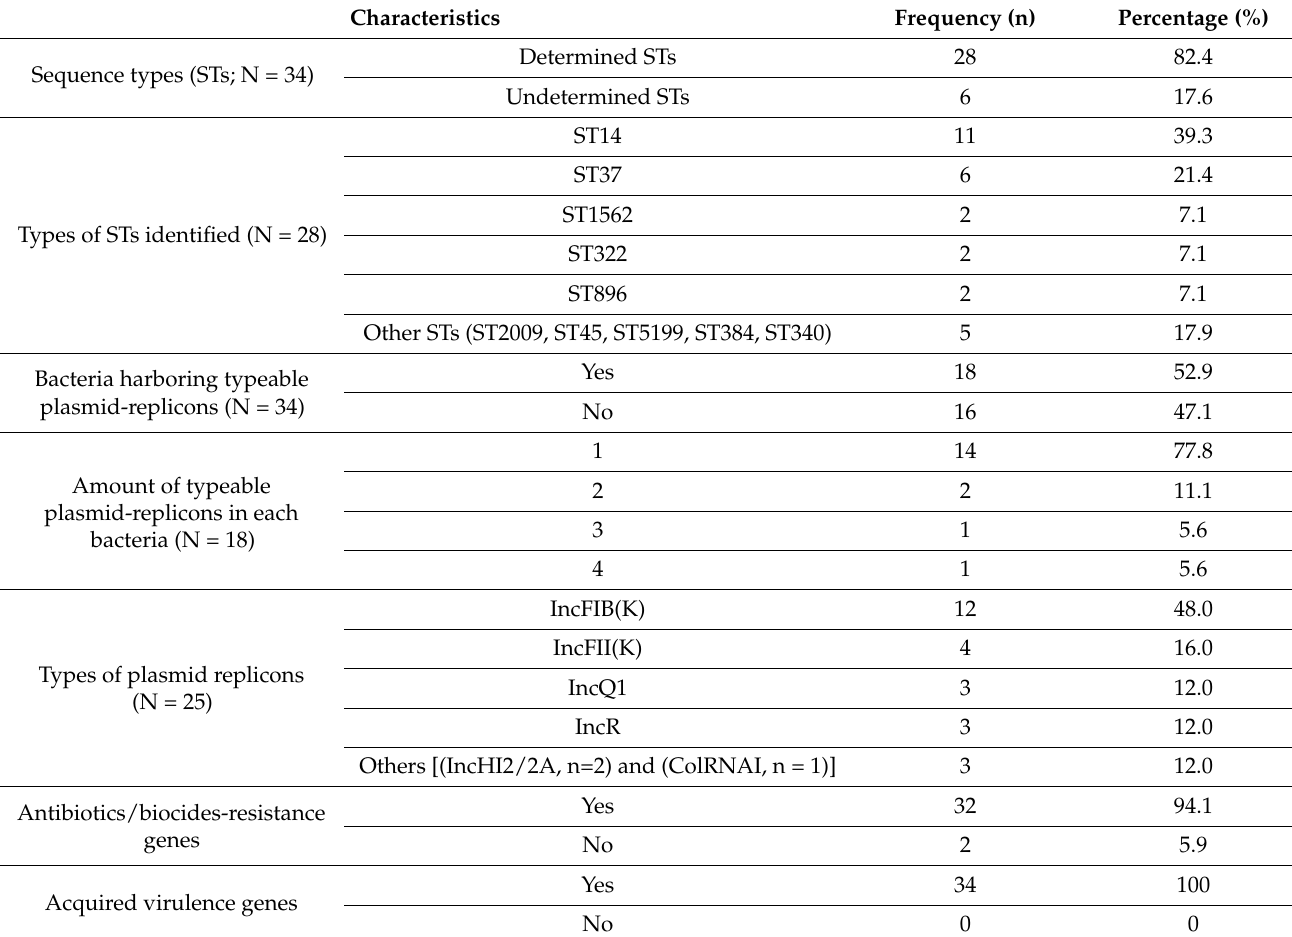
Table 1. General overview of genome-sequenced Klebsiella pneumoniae .